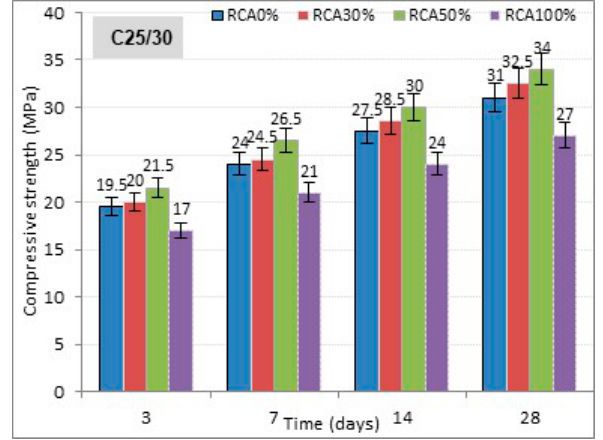
Figure 4. Compressive strength development for C25/30 concretes with various proportions of RCA.